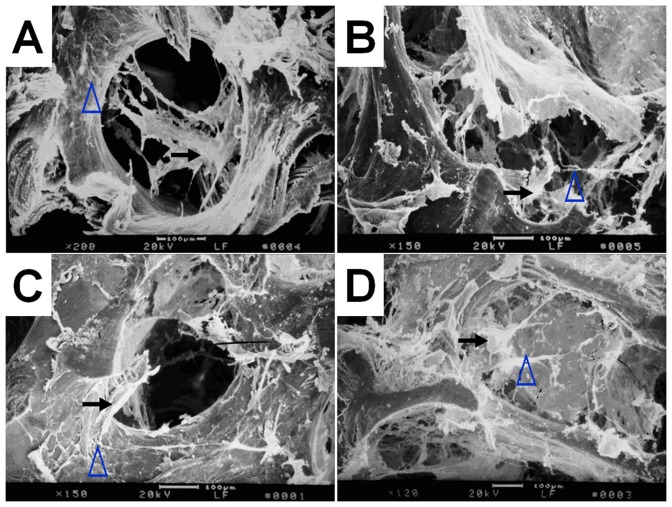
Scanning electron micrographs of cell-scaffold constructs after in vitro culture for 12 days.The attached cells and extracellular matrix (ECM) fibers presented on the scaffolds in group B (B) and group D (D) are significantly outnumber those in group A (A) as well as group C (C).Bar lengths are 100 um. The black arrows indicate cells and the blue arrows indicate ECM fibers.